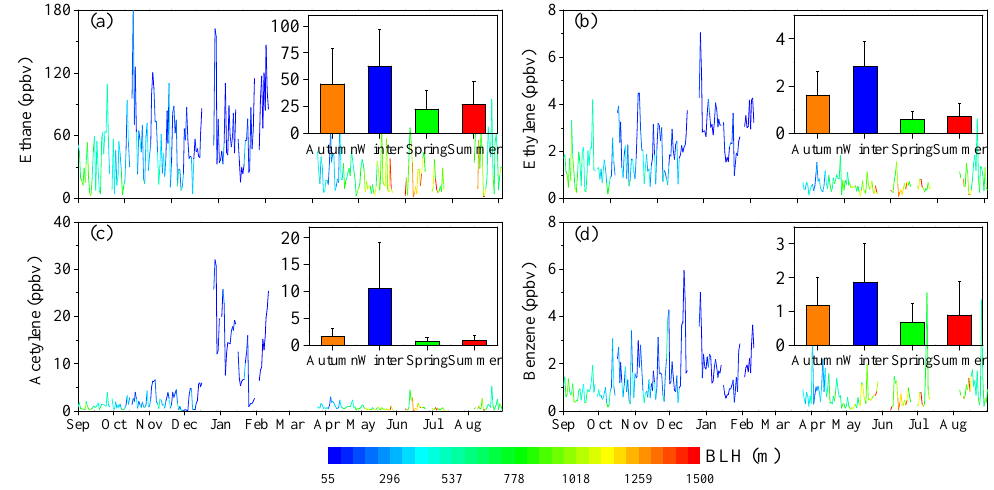
Figure 6. Seasonal and daily variations in ethane (a) , ethylene (b) , acetylene (c) and benzene (d) during the sampling period.